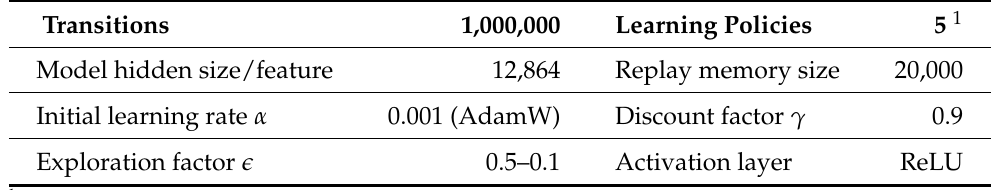
Table 1. Training